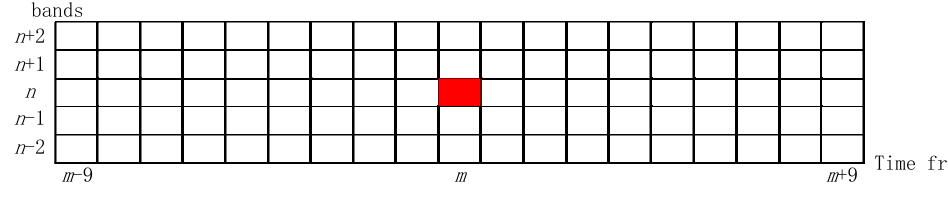
Figure 3. A MASK region centered by a selected peak (red block).